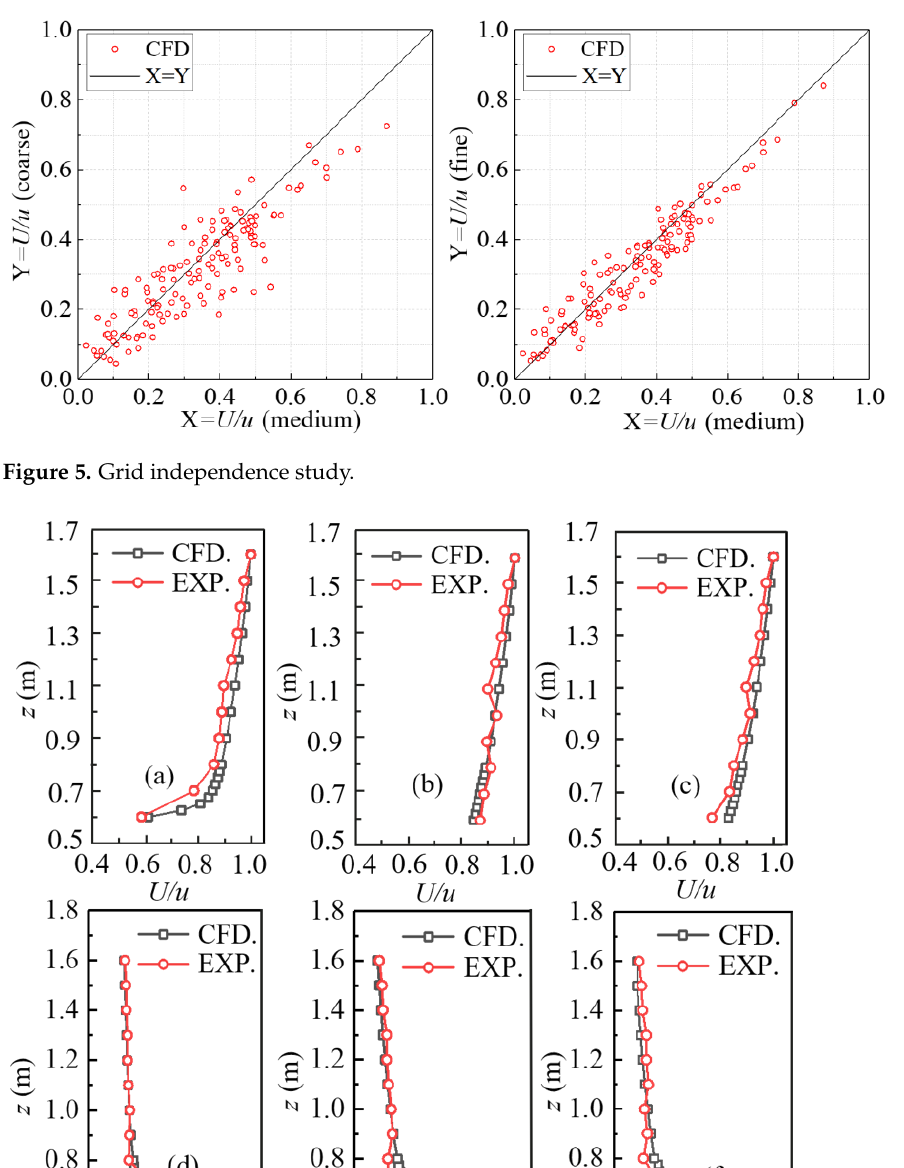
Figure 5. Grid independence study.